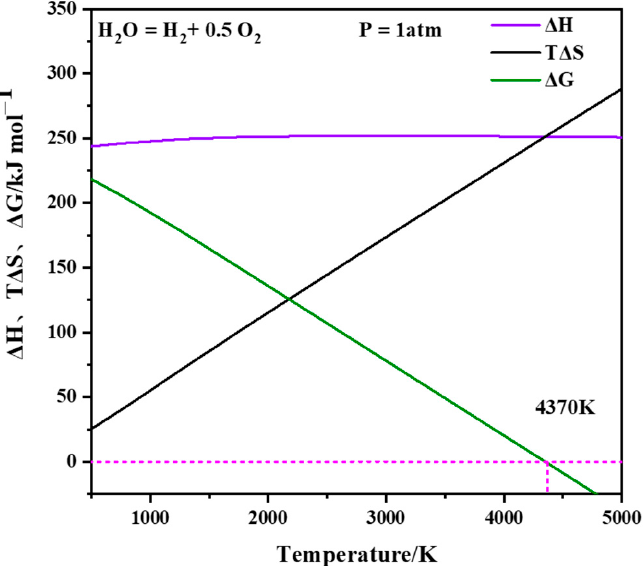
Figure 1. Variation of ∆ H, T ∆ S, and ∆ G with the temperature for direct water-splitting at 1 atm. Adapted with permission from Ref. [14], copyright 2007, American Chemical Society.